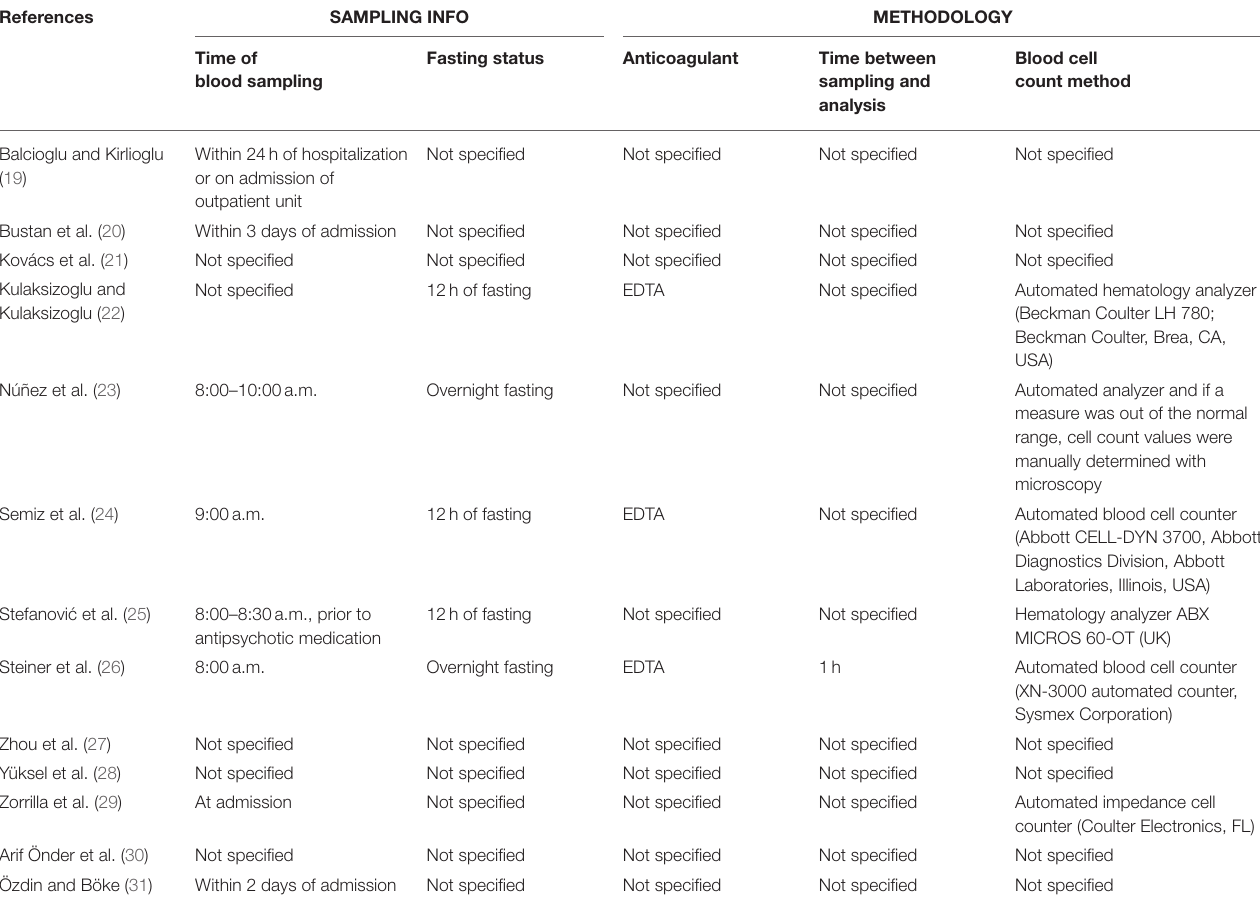
TABLE 2 | Blood sampling information in the included